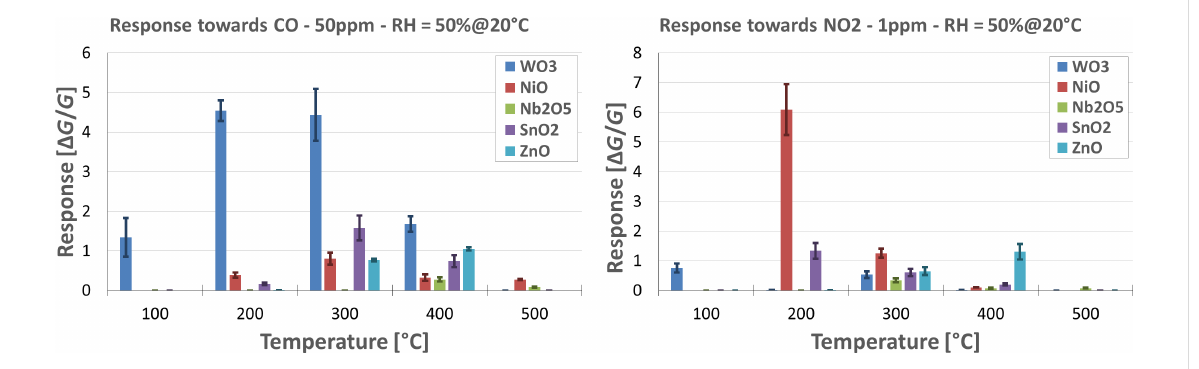
Figure 10: Sensor response towards 50 ppm of CO (left) and 1 ppm of NO 2 (right) as a function of the temperature. The relative humidity was kept constant at 50%, the temperature was 20